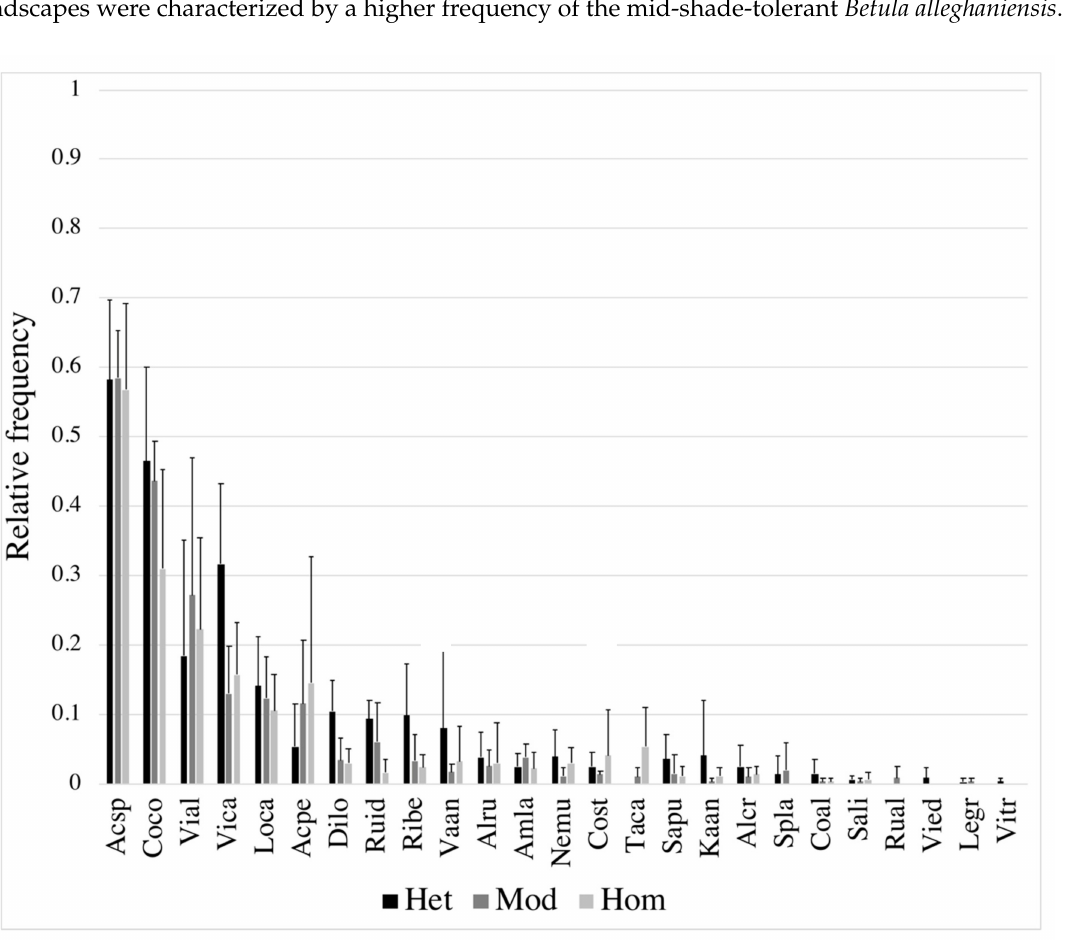
Figure 3. Relative frequencies of the shrub species in the three di ff erent landscape heterogeneity levels (heterogeneous (Het, n = 4), moderate (Mod, n = 4) and homogenous (Hom, n = 4)). Error bars represent confidence intervals ( alpha = 0.05%). Acsp: Acer spicatum ; Coco: Corylus cornuta ; Vial: Viburmum alnifolium ; Vica: Viburnum cassinoides ; Loca: Lonicera canadensis ; Acpe: Acer pensylvanicum ; Dilo: Diervilla lonicera ; Ruid: Rubus ideaeus ; Ribe: Ribes spp.; Vaan: Vaccinium angustifolium ; Alru: Alnus rugosa ; Amla: Amelanchier leavis ; Nemu: Nemopanthus mucronata ; Cost: Cornus stolonifera ; Taca: Taxus canadensis ; Sapu: Sambucus pubescens ; Kaan: Kalmia angustifolia ; Alcr: Alnus crispa ; Spla: Spirea latifolia ; Coal: Cornus alternifolia ; Sali: Salix spp.; Rual: Rubus alleghaniensis ; Vied: Viburnum edule ; Legr: Ledum groenlandicum ; Vitr: Viburnum trilobata